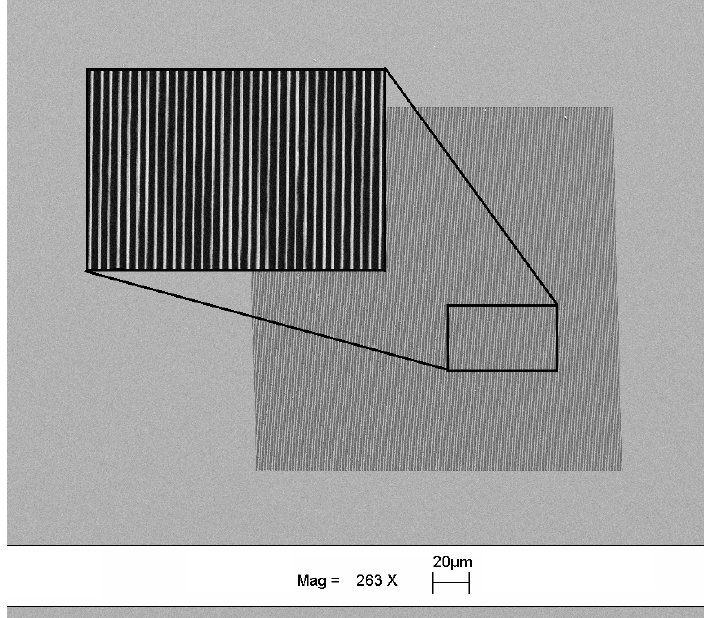
Figure 3. SEM image of silicon gratings fabricated using e-beam